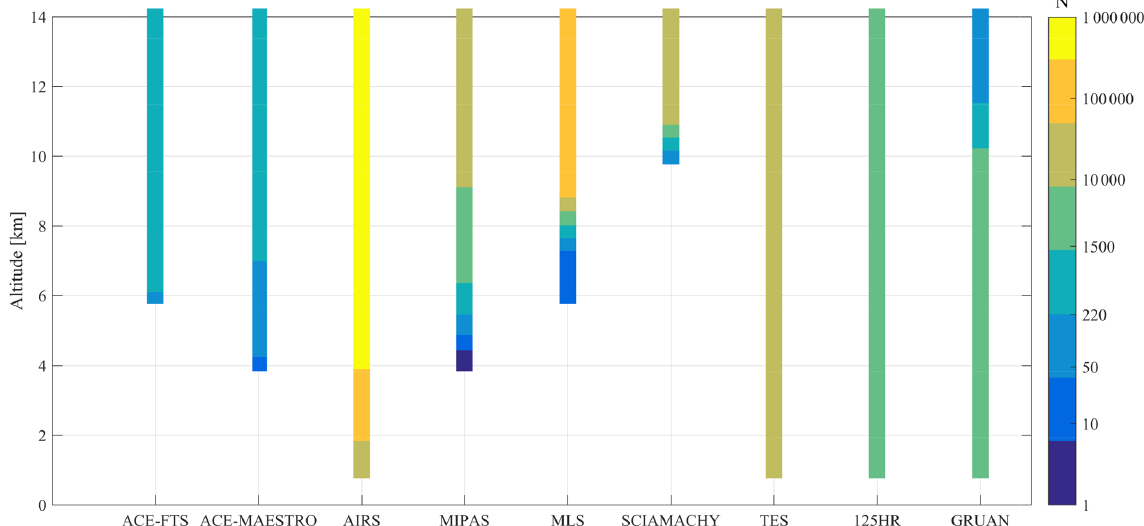
Figure 2. Vertical range of datasets used in this study. Colour range showing the number of profiles at each altitude level shows the log( N ).